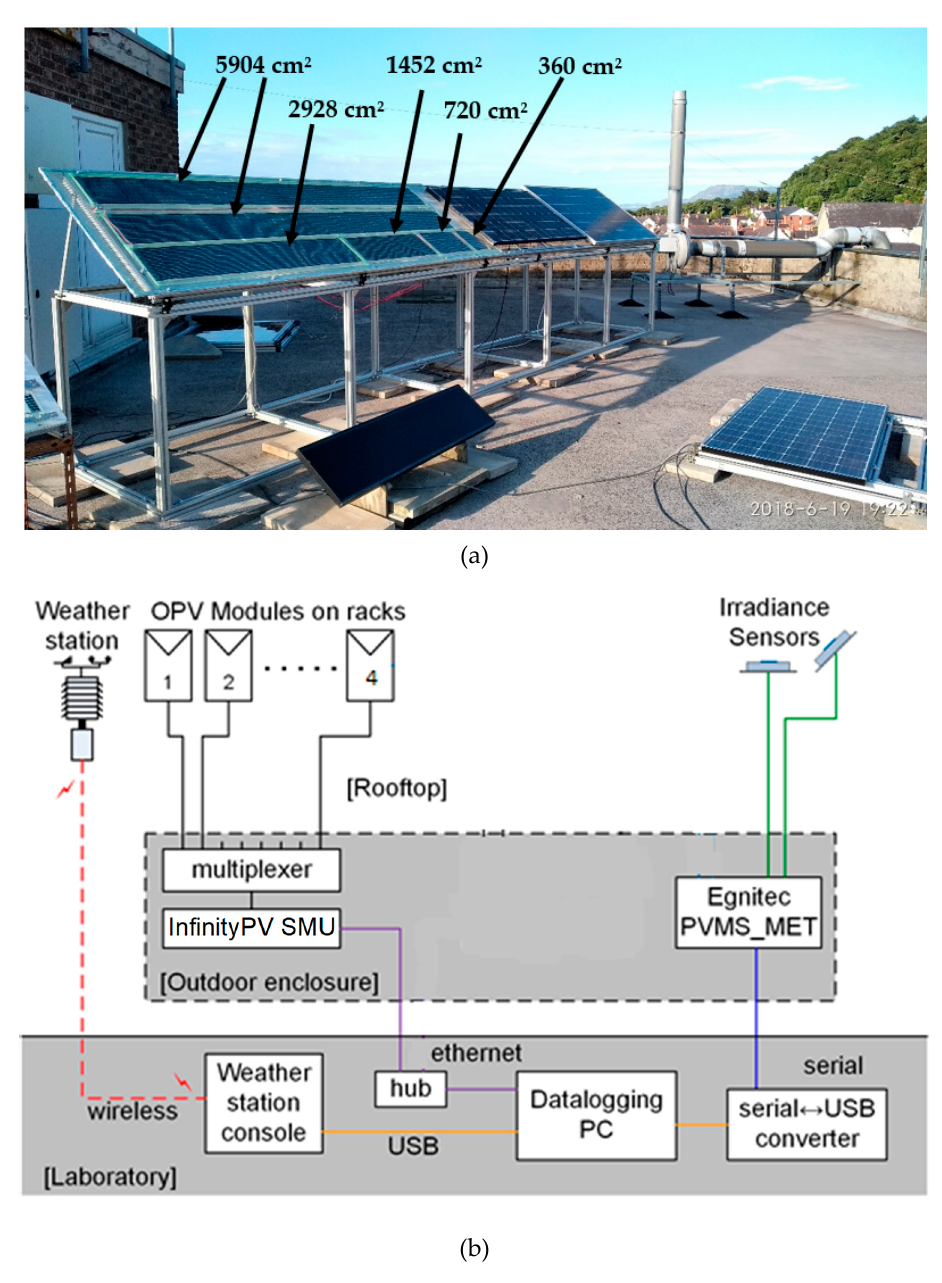
Figure 1. (a) Image of mounted OPV modules positioned due South at the School of Electronic En- Engineering, Bangor University and ( b ) a schematic of the experimental gineering, Bangor University and (b)a schematic of the experimental setup.